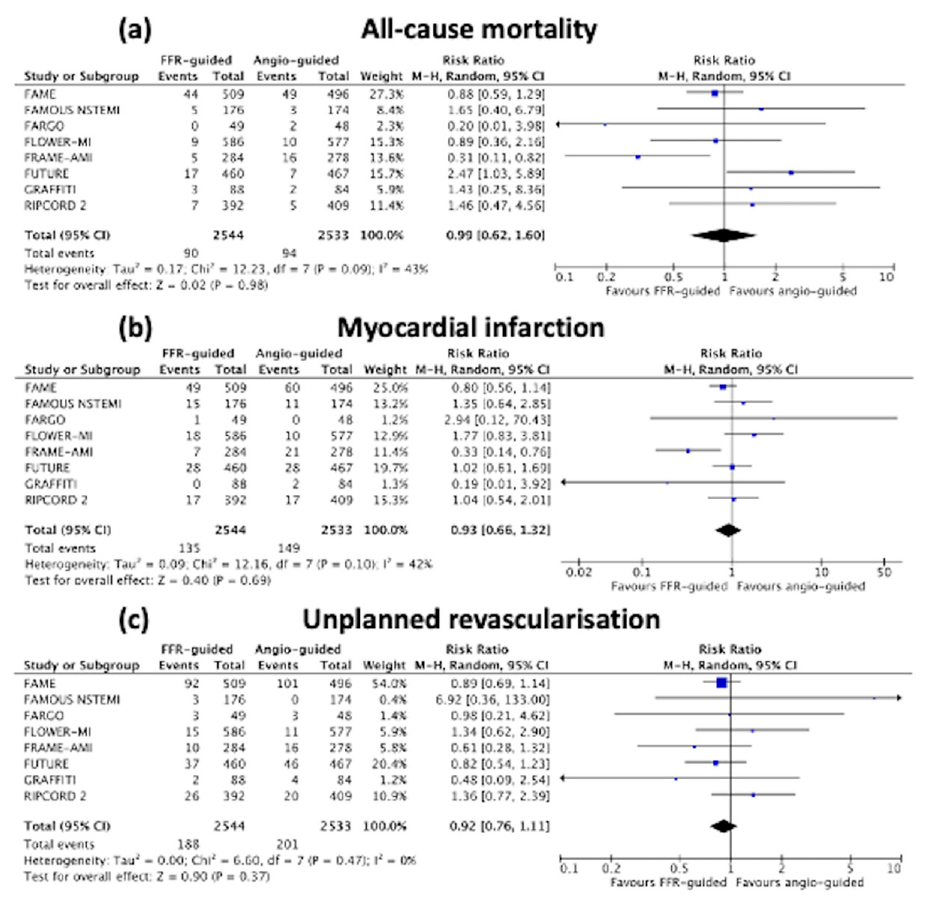
Figure 4. Forest plots of ( a ) all-cause mortality; ( b ) non-fatal myocardial infarction; and ( c ) unplanned revascularisation.